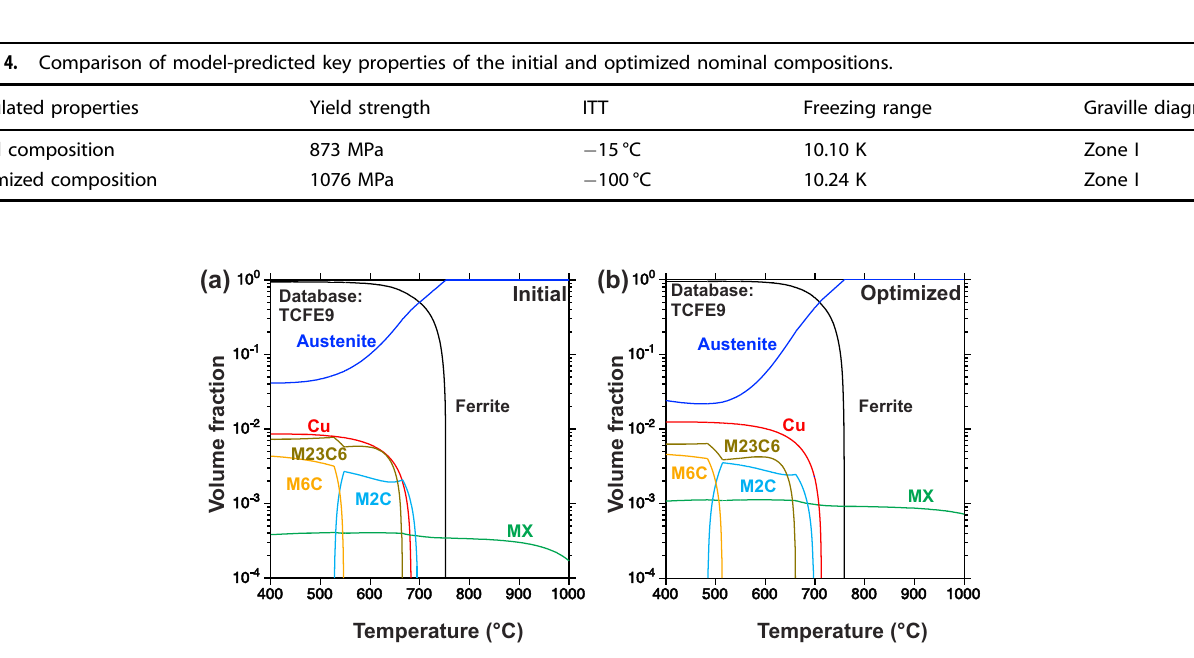
Fig. 7 Equilibrium phase fraction plots as a function of temperature. Diagrams of a initial and b optimized compositions calculated using the TCFE9